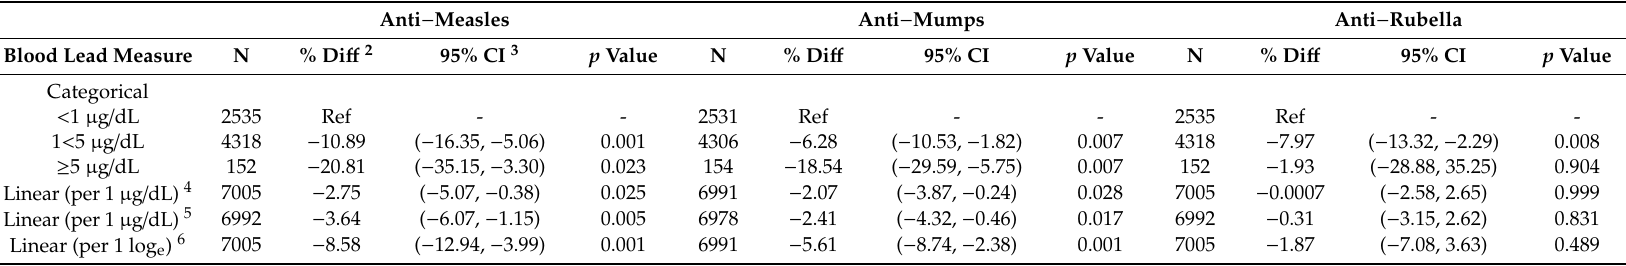
Table 1. Adjusted 1 percent change in anti-measles, anti-mumps, and anti-rubella levels in relation to child blood lead concentration.